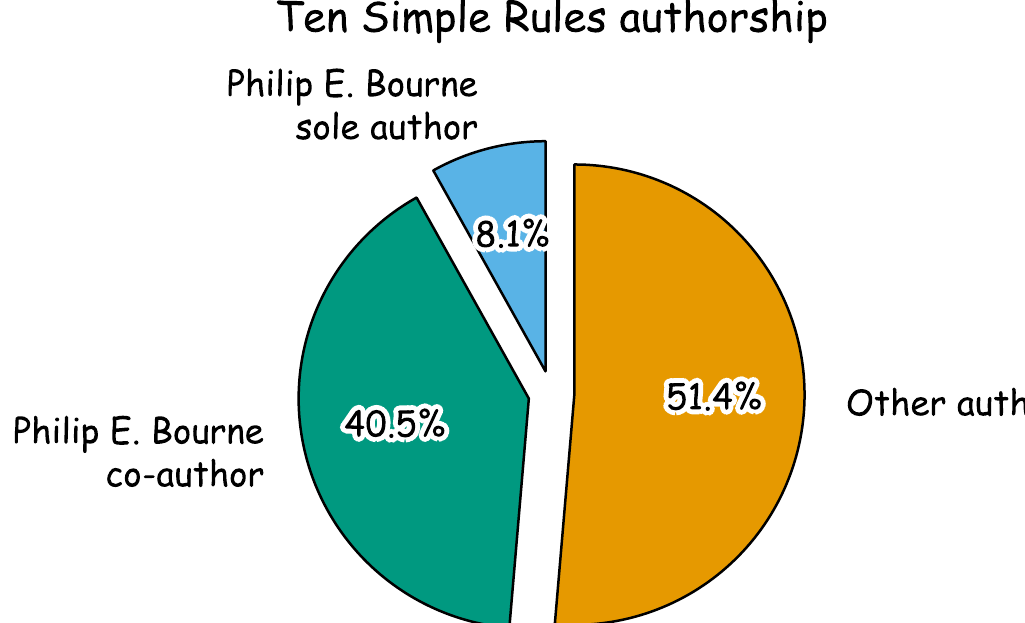
Figure 2. Your best chance of having a PLOS Ten Simple Rules article published is by being Philip E. Bourne.